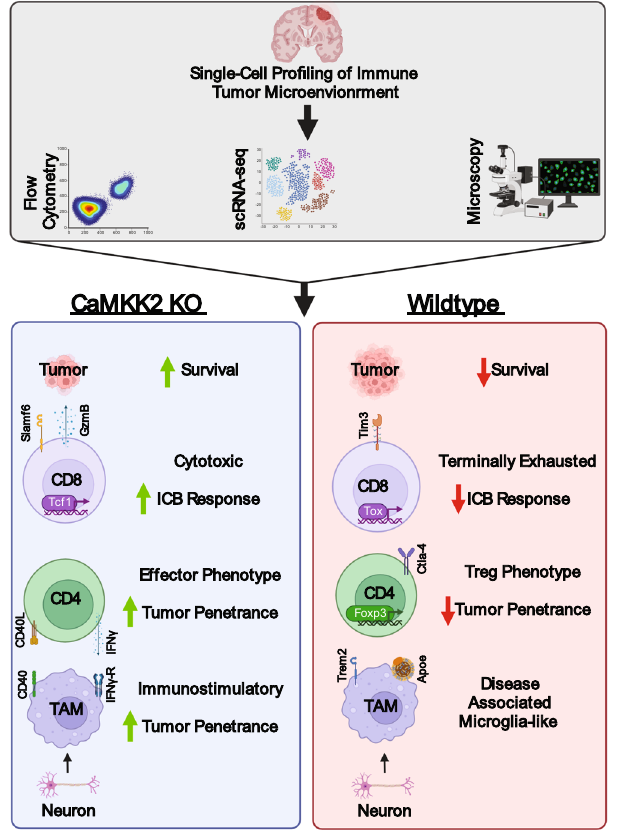
Fig. 8 | Working model of CaMKK2 ’ s mechanism of action for promoting immunotherapeutic resistance. Graphical summary of fi ndings. Green and red arrows refer to the increased or decreased presence of a phenotype, respectively. Graphic was created with